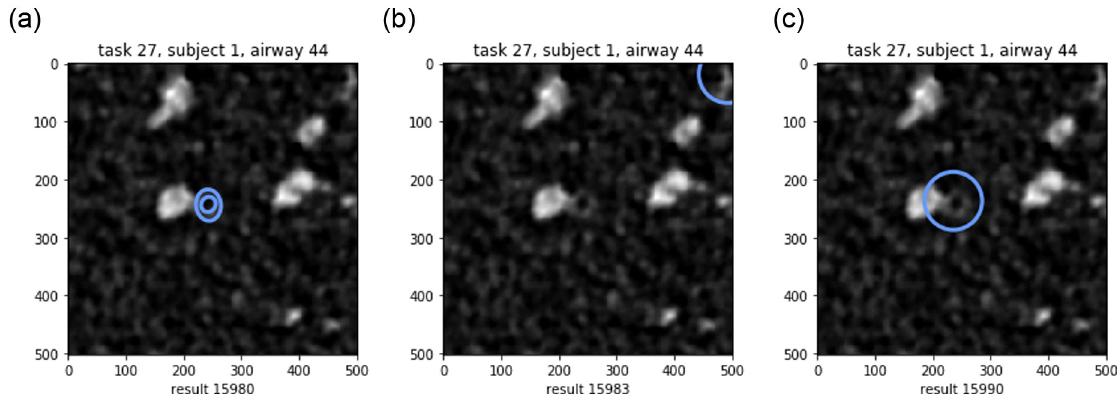
Fig 3. Example results acquired for the same task: Valid result with two annotations, and two invalid results: A worker who indicates not seeing an airway, and a worker who detects the airway but does not outline it.